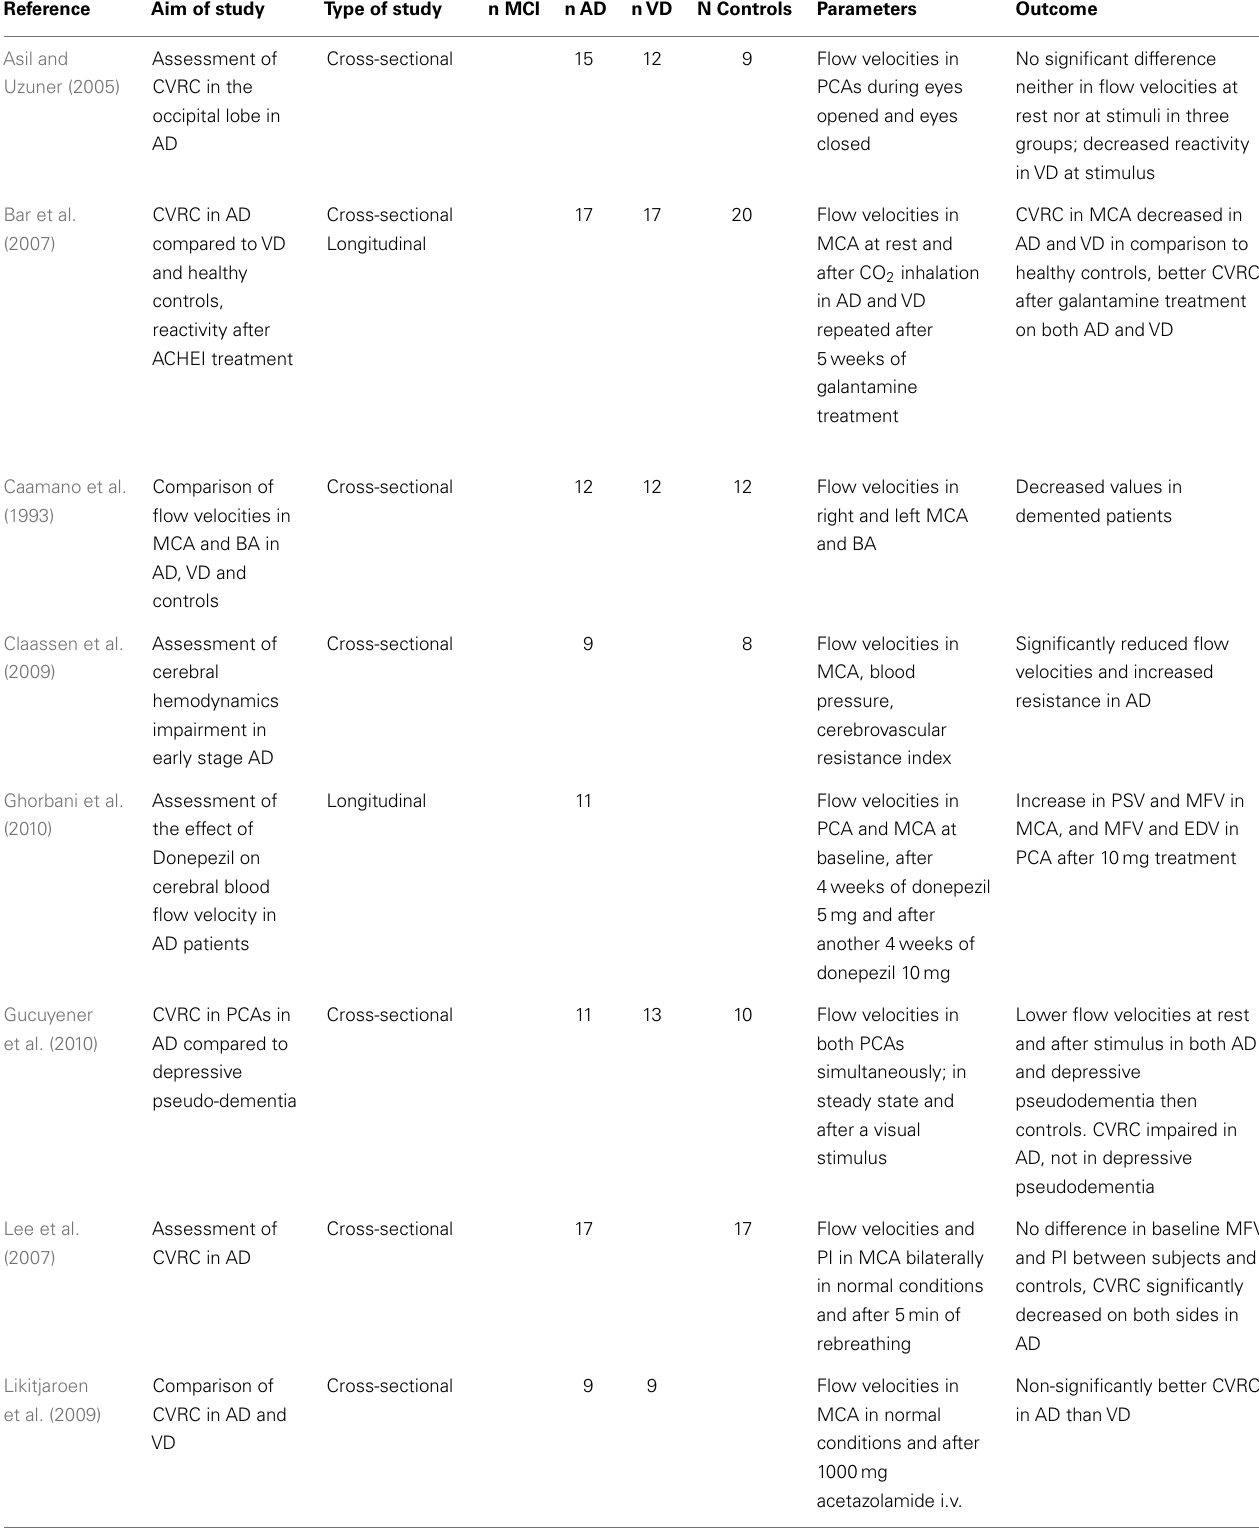
Table 3 | Flow velocities, cerebrovascular resistance, and cerebrovascular reserve